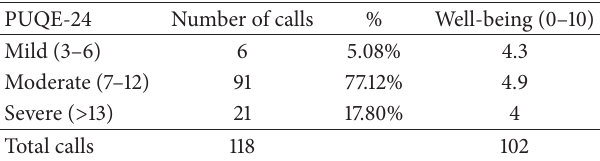
Table 3: Overall PUQE-24 and well-being scores from USA callers.